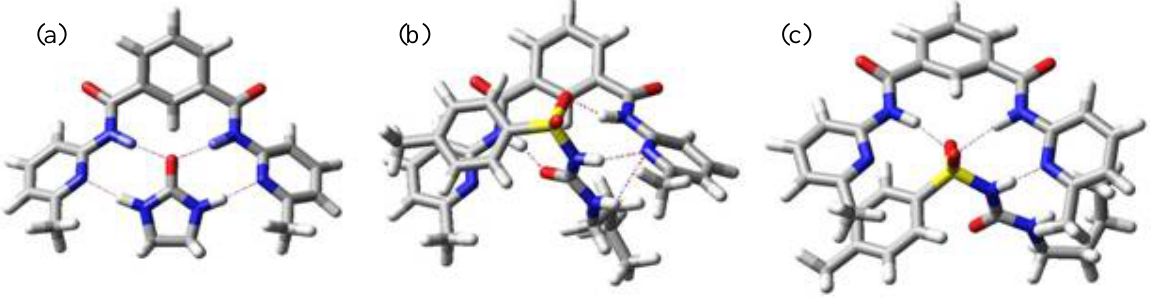
Figure 4. Minimum energy structure for complexes I : 4 (a), I : 1 (b) and I : 1 (NOESY) (c)